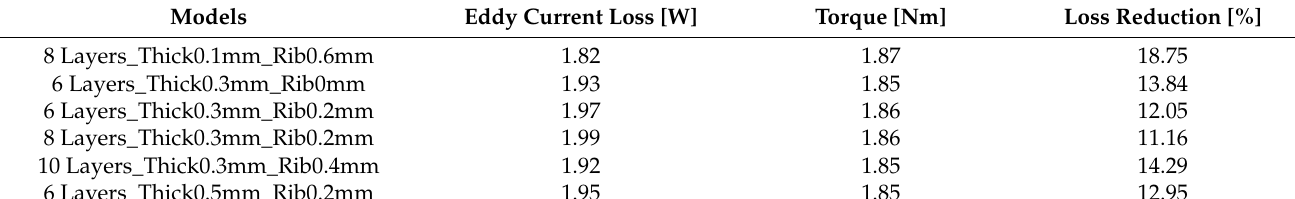
Figure 7. Satisfied eddy current loss and torque graph.